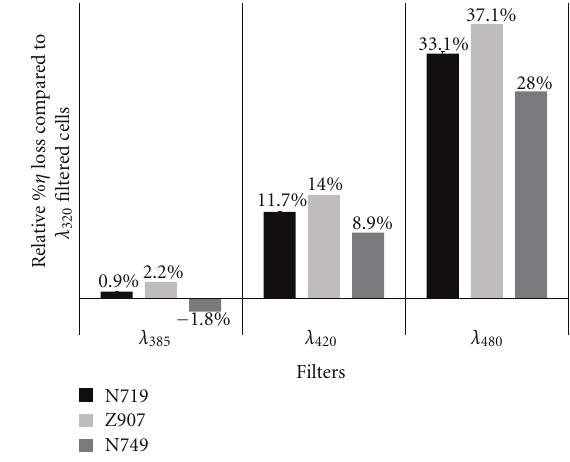
Figure 6: E ffi ciency losses caused by the filters shown compared to cells filtered with the λ 320 filter.